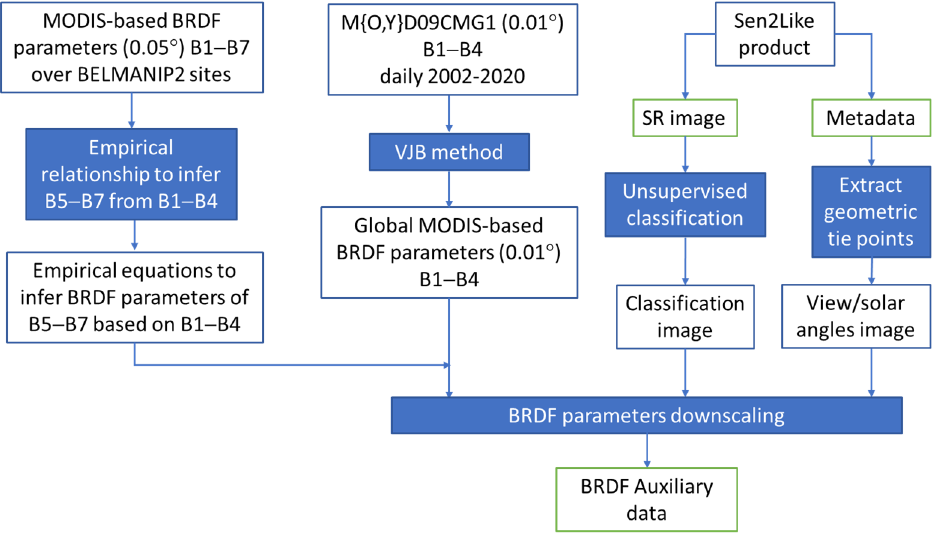
Figure 5. Workflow of the BRDF auxiliary data generation.